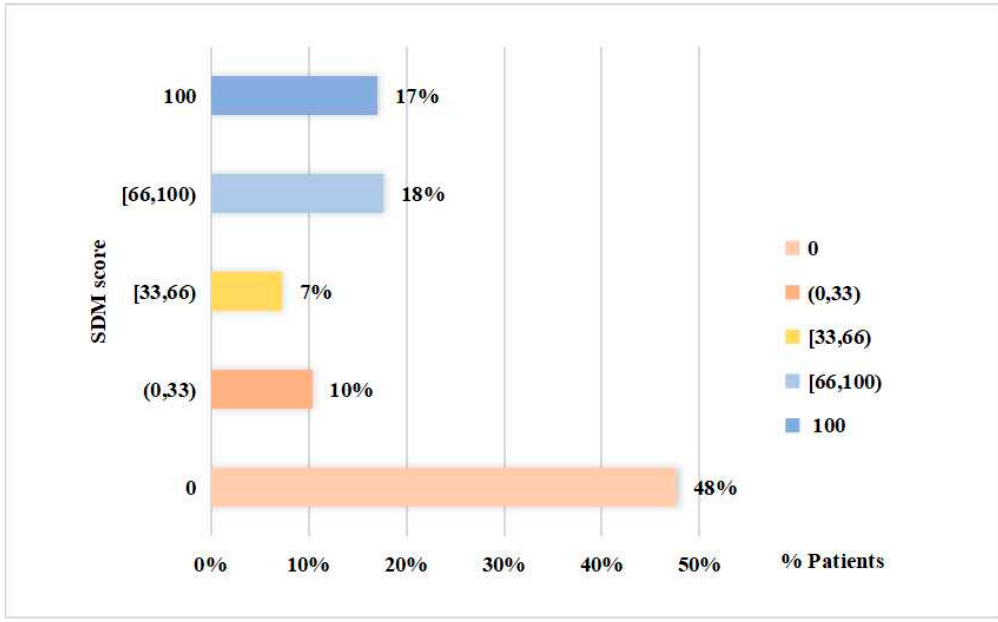
Figure 3. SDM-Q-9 scores distribution.